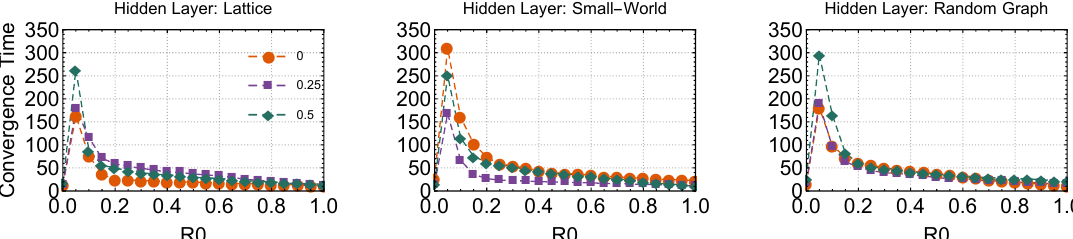
Figure 5. Convergence simulation time. Results over the initial fraction of R -agents R 0 , for three different hidden layer topologies: (i) a lattice ( β = 0, left), (ii) a Watts–Strogatz small-world ( β = 0.1) and (iii) a random graph ( β = 1). Data points are relative to no social learning ρ L = 0 (orange circles), moderate social learning ρ L = 0.25 (purple squares) and high-rate social learning ρ L = 0.5 (green diamonds). Every data point is averaged over 50 different replicates. Error bars are of the same size of